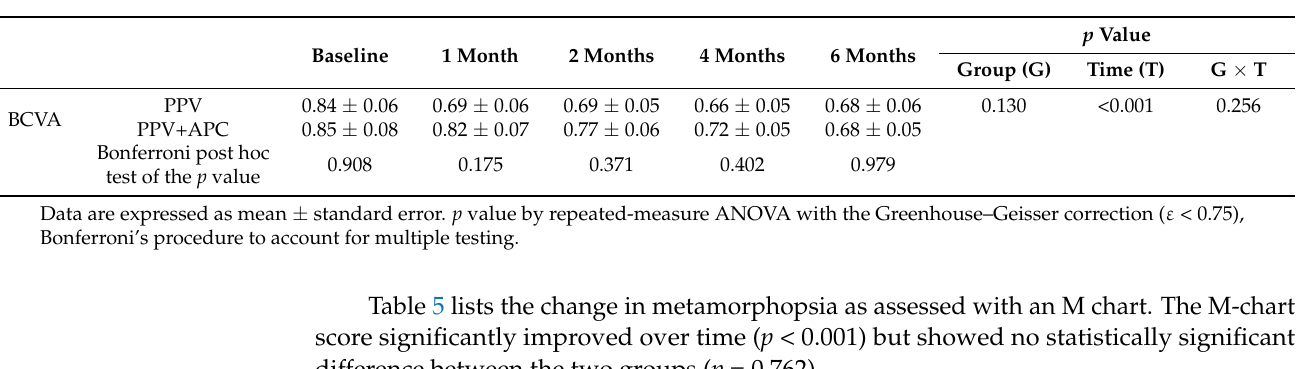
Table 4. Comparison of mean best-corrected visual acuity (BCVA) between the two groups.